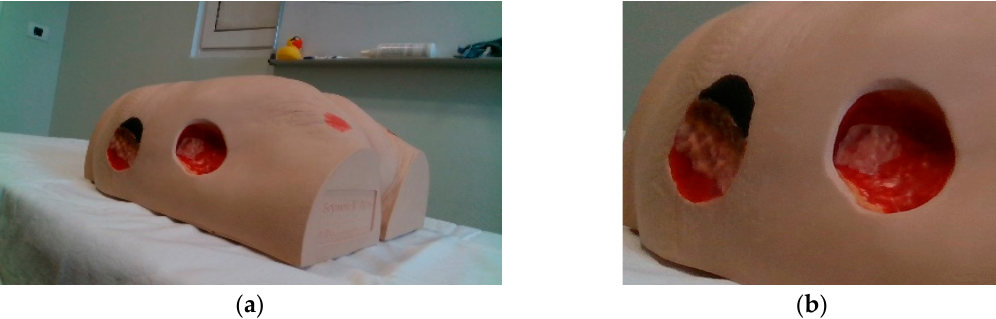
Figure 5. Sample image: ( a ) whole image; ( b ) enlarged section of the original image.